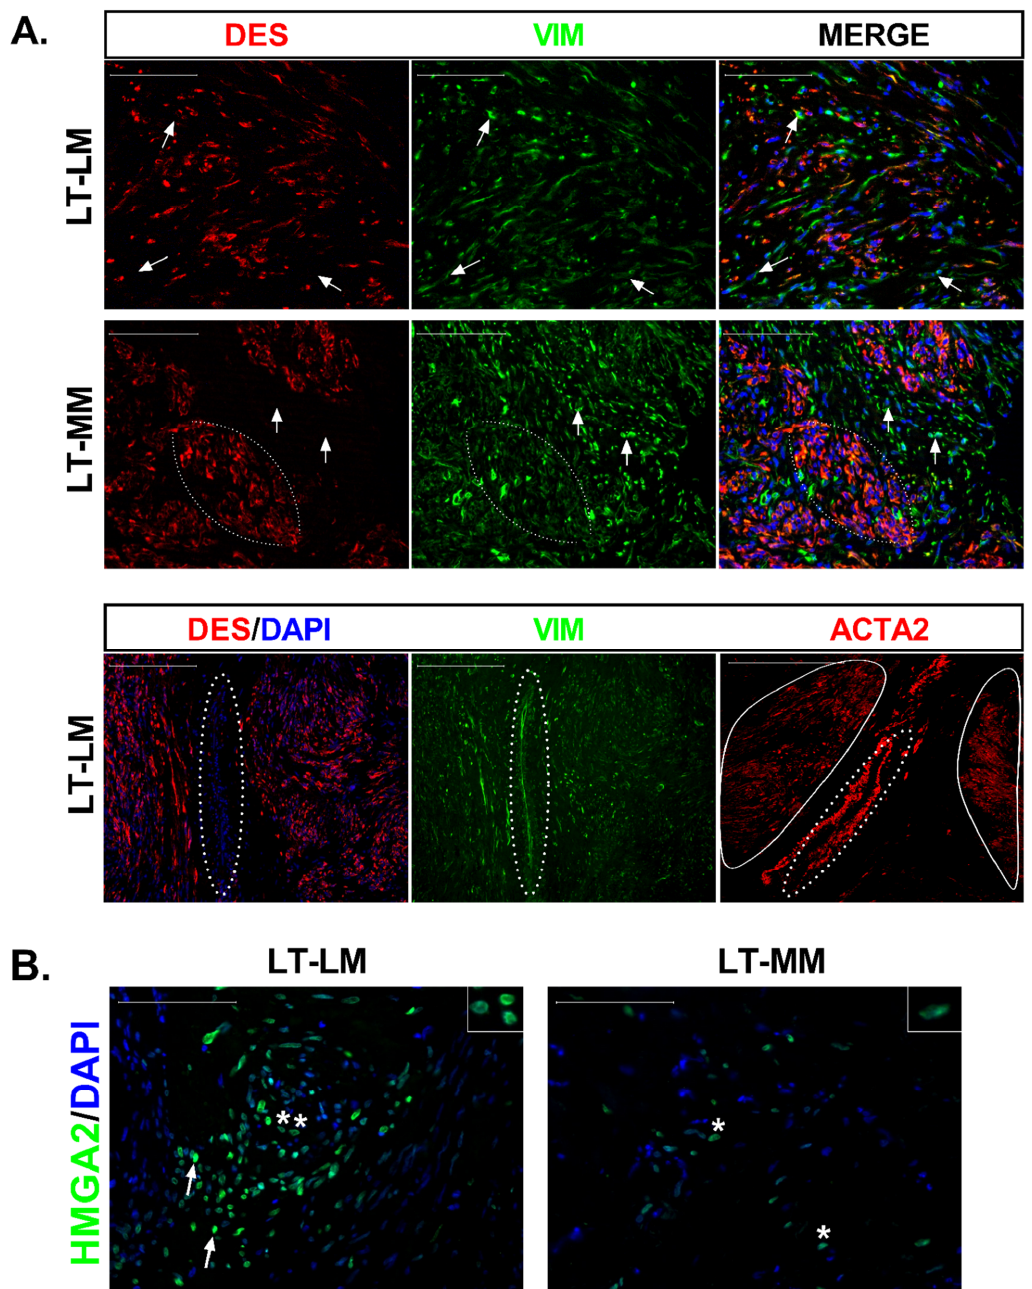
Figure 1. Characterization of cells that repopulated leiomyoma slices and expression of HMGA2 protein. ( A ) Tissue distribution of smooth muscle cells (SMC), fibroblasts (FB), and myofibroblasts at long-term culture (LT) of leiomyoma (LM) and myometrium (MM) slices. DES (red) stains SMCs, whereas VIM (green) stains both SMCs and FBs. DAPI stained cell nucleus (blue). Arrows in DES image point to the DES negative but VIM positive cells. Most of the cells in the reconstituted slices were DES + /VIM + (Merge), with few fibroblasts (DES − /VIM + ) dispersed among them (white arrows). Scale bar, 100 µ m. The lower images show the colocalization of DES (red) and VIM (green) in an LM section and immunostaining with ACTA2 antibody in the next section. Myofibroblasts (DES − /VIM + /ACTA2 + ; dashed circle) were detected between two smooth muscle bundles (continuous circle). ( B ) Immunostaining of tissue sections with HMGA2 (green) demonstrated cells with strong (white arrows) and weak (asterisks) signals in LM slices at long-term culture (LT). MM slices showed fewer immunostained cells with lower HMGA2 expression (asterisks). The inserts (top right) show the nuclear immunoreaction. Scale bar, 100 µ